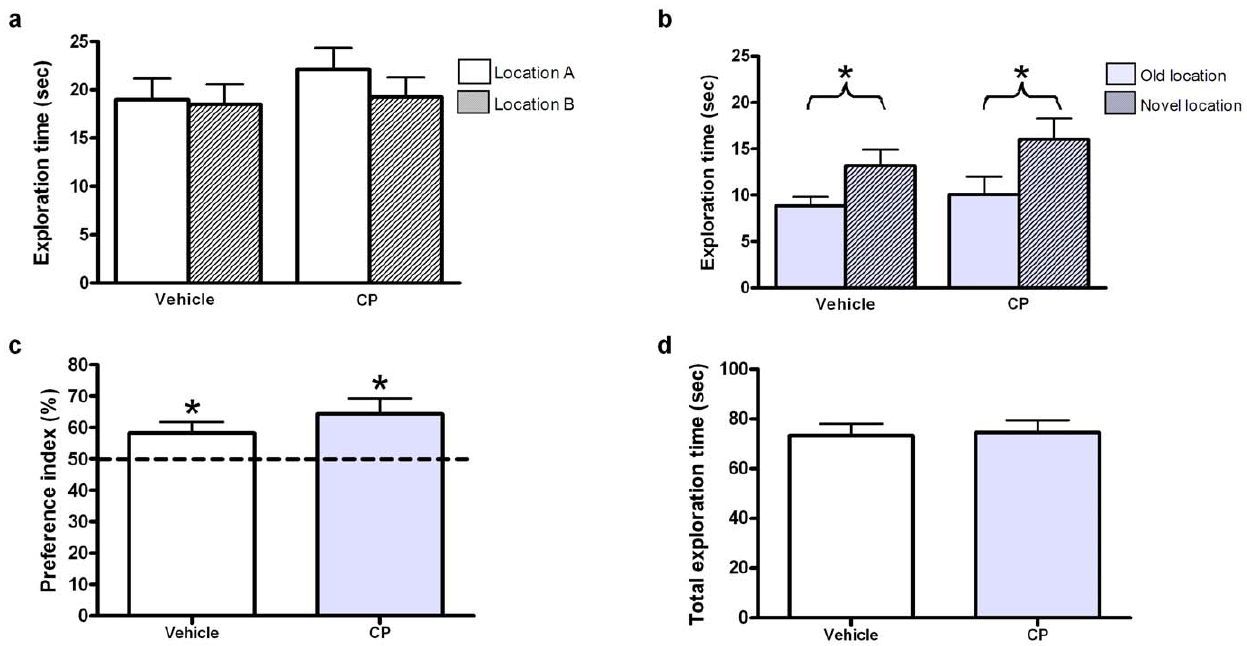
Figure 2. Novel location recognition (NLR) task. Mean exploration times (mean 6 SEM) of the rats for each object in the familiarisation (a) and choice (b) trials of the NLR task. There was no significant difference in exploration time of either object for both groups in the familiarisation trial ( p . 0.05). In the choice trial, both groups spent significantly longer exploring the object in the novel location ( p , 0.05). Preference indices (PI, (c), mean 6 SEM) were created by expressing time spent exploring the object in the novel location as a percentage of the sum of exploration time of novel and familiar locations in the choice trial (Bruel-Jungerman et al. 2005). Both groups were significantly different from chance ( p , 0.05). The total exploration time (mean 6 SEM) for both trial combined (d) did not differ significantly between groups ( p . 0.05).